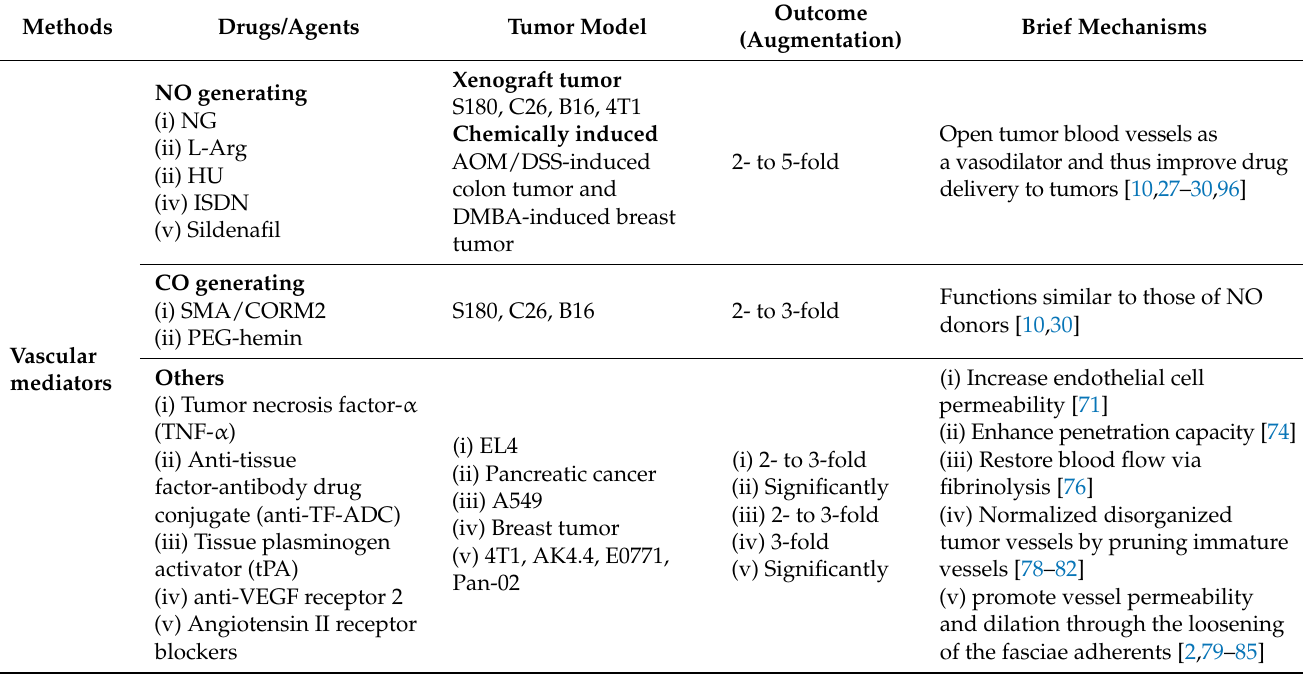
Table 1. EPR effect enhancers used to improve drug accumulation in tumors and their modes of